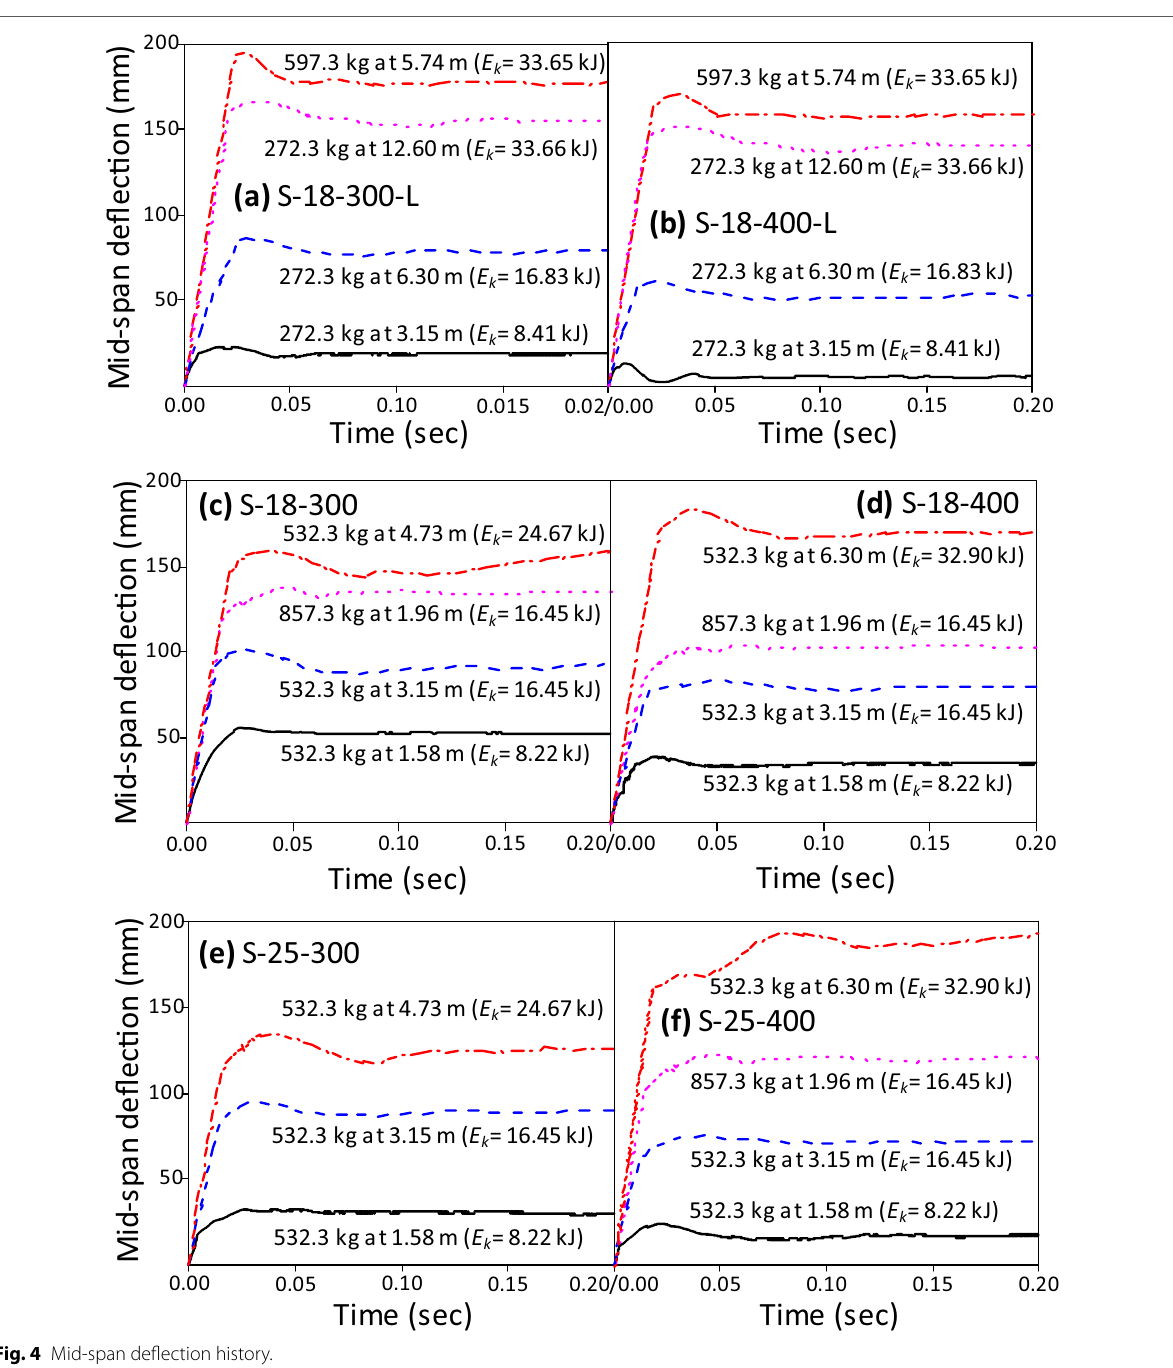
(4) after collision, the RC beam with steel jig and dropped mass move together with the same velocity V c based on a perfectly plastic collision (Suzuki et al. 1996); and (5) the potential energy E p due to the deflection δ after collision causes additional damage and deflection. In the energy